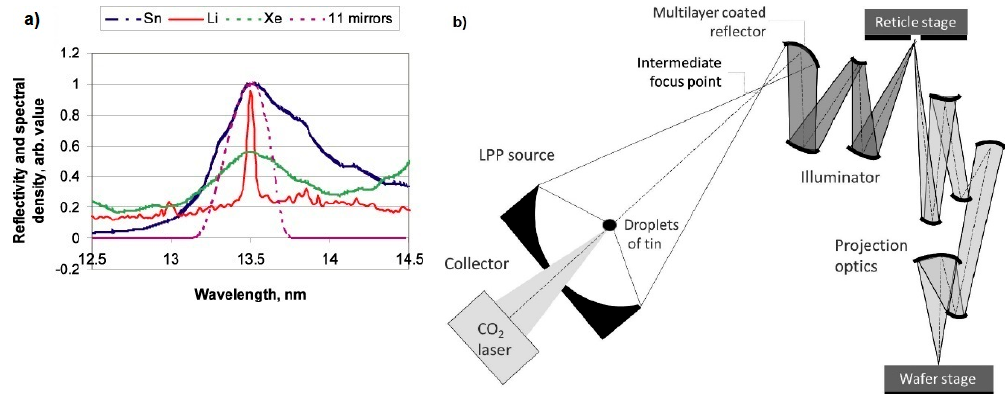
Figure 1. Extreme ultra violet (EUV) technology characteristics: ( a ) Emission of different sources based on Sn, Xe, and Li at the EUV spectral region and calculated near normal incidence reflectivity of a 11 mirror system in the same area. Adapted from [25], with permission from IOP Publishing, 2020 ( b ) A scheme of a EUV lithography system where the different parts, including source, illuminator, reticle stage (mask), and projection optics are depicted. Adapted from [17], with permission from De Gruyter, 2020.